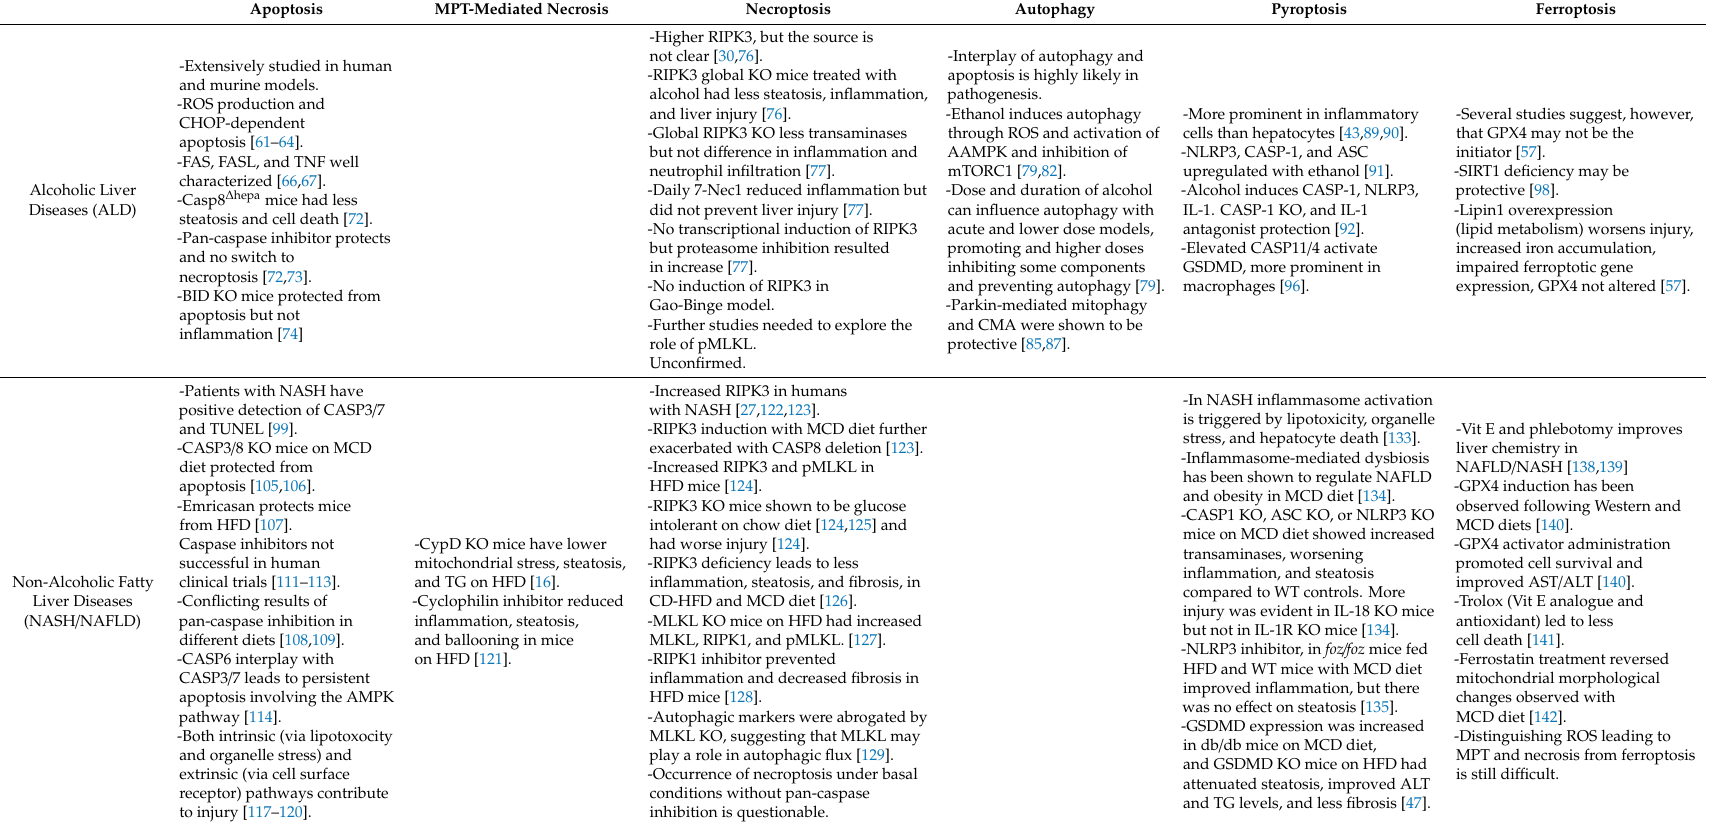
Table 1. Main findings of cell death modes in liver